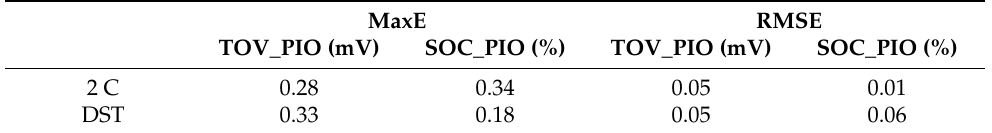
Table 1. Results of the TOV/SOC errors based on